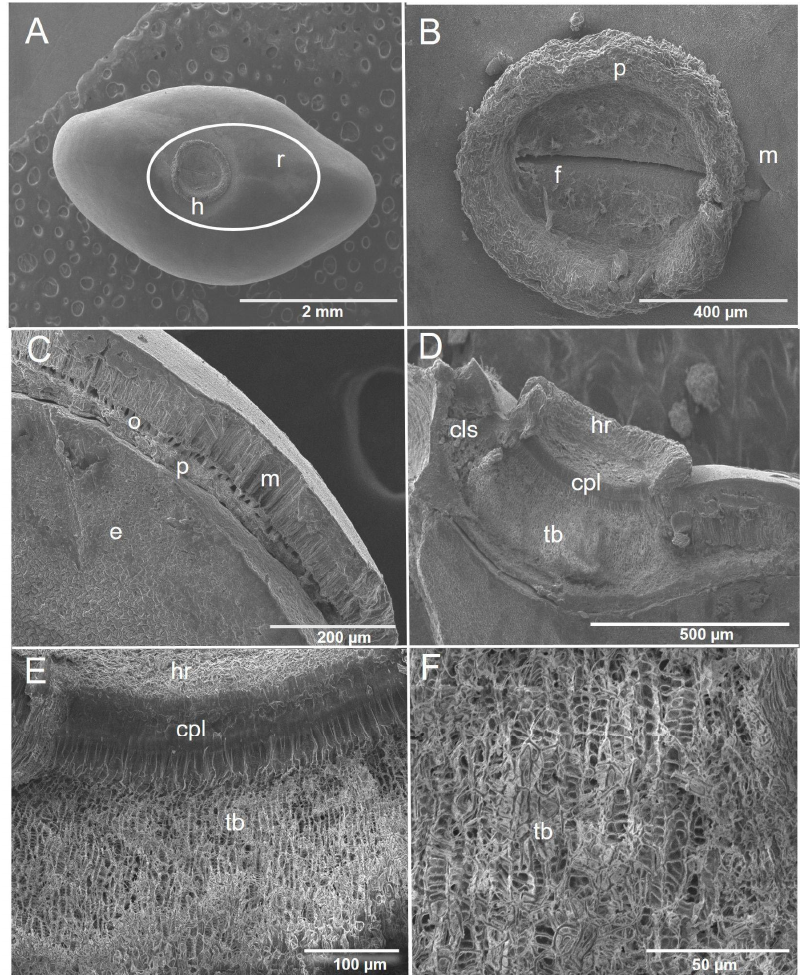
Figure 3. Morphological characterization of the Piscidia piscipula seed coat. ( A ) External section, h, hilum, r, raphe, ( B ) Detail of the hilar region: f, hilar fissure, p, funicular parenchyma, m, mi- cropyle, ( C ) Longitudinal section of the epidermis: e, embryo, m, macrosclereids, o, osteoscle- reids, p, parenchyma, ( D ) Longitudinal section of the hilar region: cls, cushion-like structure, cpl, counter-palisade layer, hr, hilar region, tb, tracheid bar, ( E ) Detail of interior of hilar region, cpl, counter-palisade layer, hr, hilar region, tb, tracheid bar, and ( F ) Approach to the tracheid bar cell, tb, tracheid